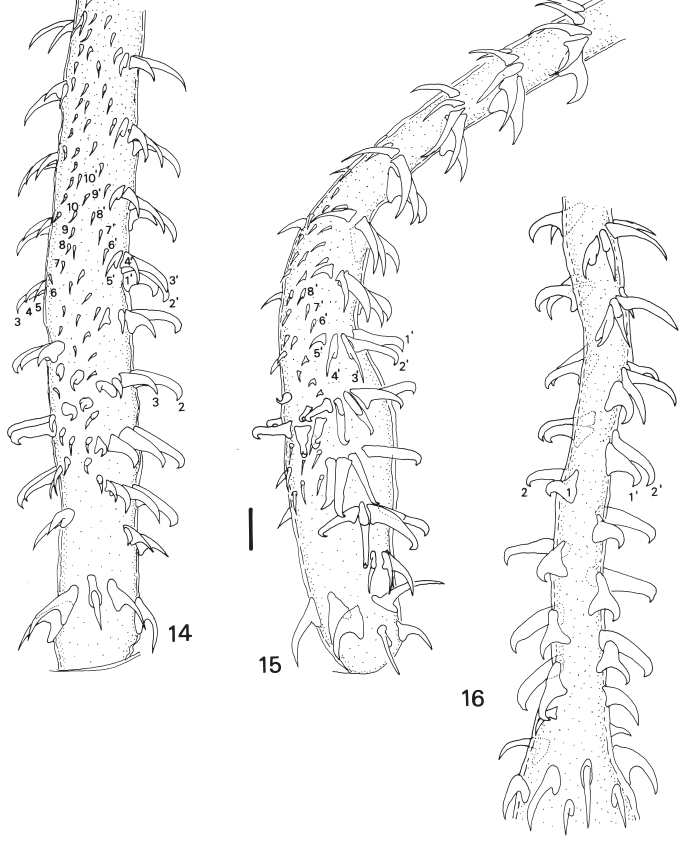
Figs 14-16. – Pseudochristianella nudiscula sp. nov. from Rhinobatos productus (Rhinobatidae). Fig. 14. Tentacle, external surface, bothrial surface on right hand side, basal and metabasal armature. Fig. 15. Tentacle, bothrial sur- face, internal surface on right hand side, basal and meta- basal armature. Fig. 16. Tentacle, internal surface, bothrial surface on right hand side, basal and metabasal armature. Scale-line: 0.01